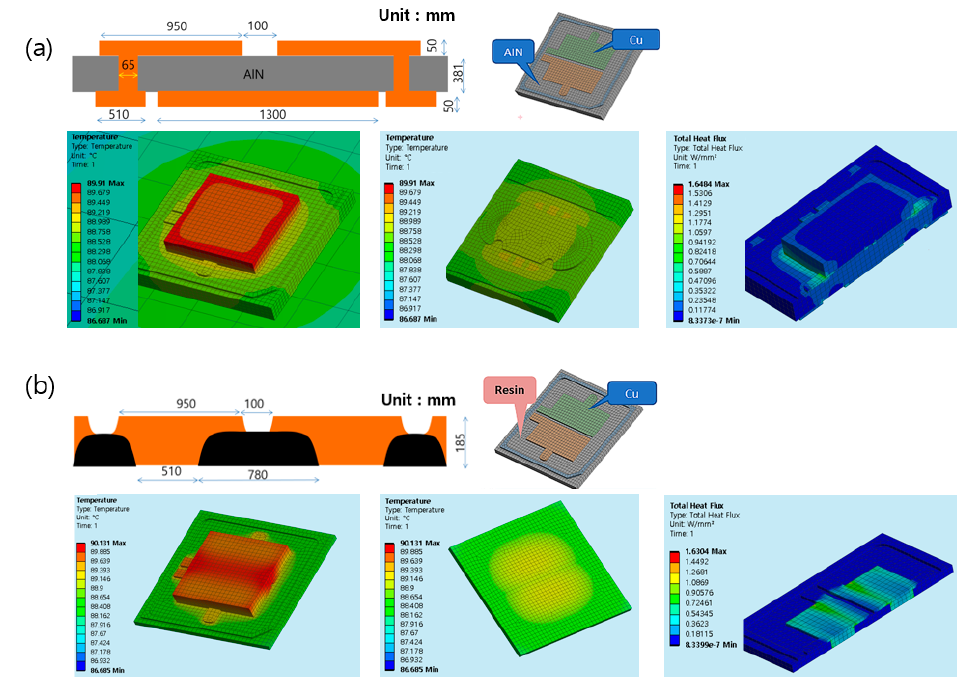
Figure 12. Comparison of heat dissipation performance between Ceramic and Rt-QFN substrate: ( a ) AlN Substrate; ( b ) Rt-QFN Substrate.